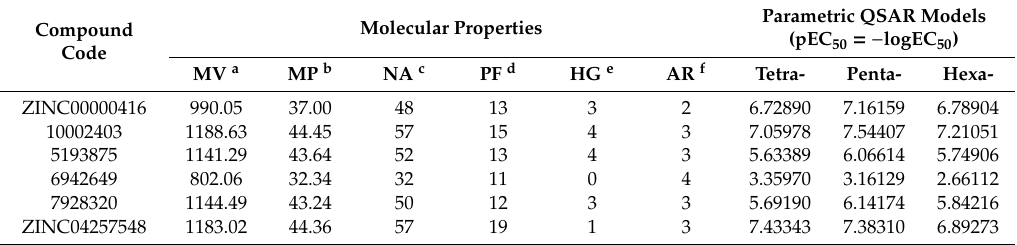
Table 9. Compounds selected by virtual screening and descriptors used in the QSAR